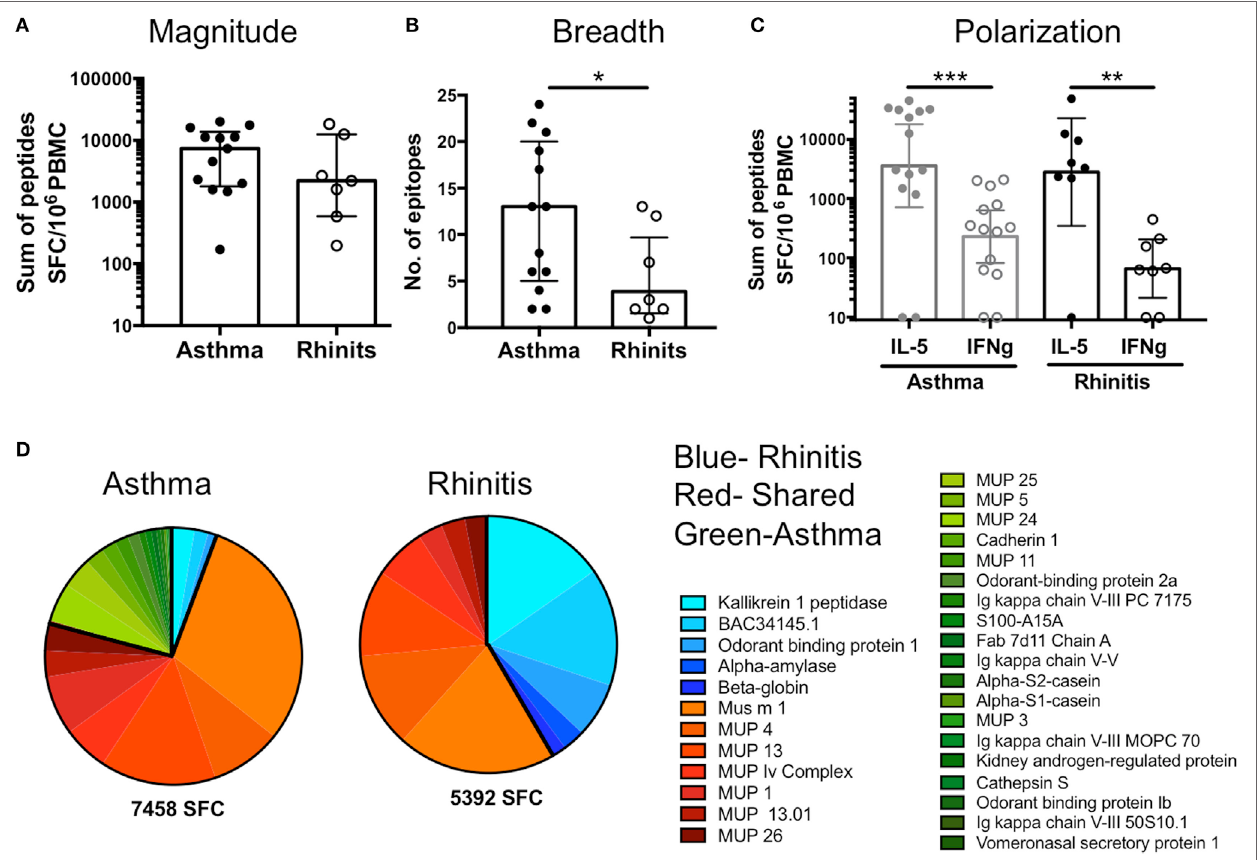
FigUre 5 | Differences in T cell reactivity in asthmatic versus rhinitic donors. (a) Response magnitude, (b) breadth of response, (c) cytokine polarization and (D) antigen immunodominance were assessed in asthmatic ( n = 13) and rhinitic ( n = 7) donors. Antigens predominantly recognized in asthmatic donors are shown in green, antigens recognized by both cohorts are shown in red and antigens predominantly recognized by rhinitic donors are shown in blue. Statistical analysis was performed by Mann–Whitney test, one-tailed. * p < 0.05, ** p < 0.01, and *** p < 0.001.